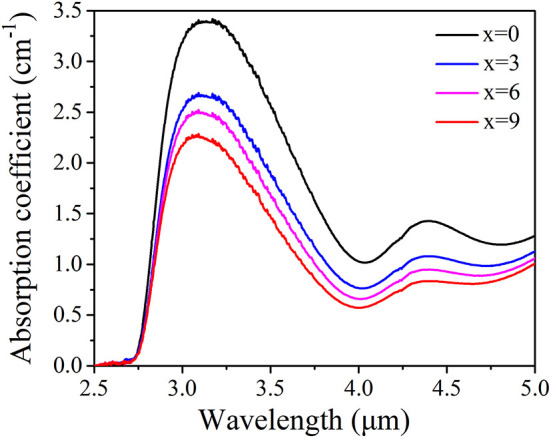
FTIR spectra of TGB glasses with different proportions of BaF2.